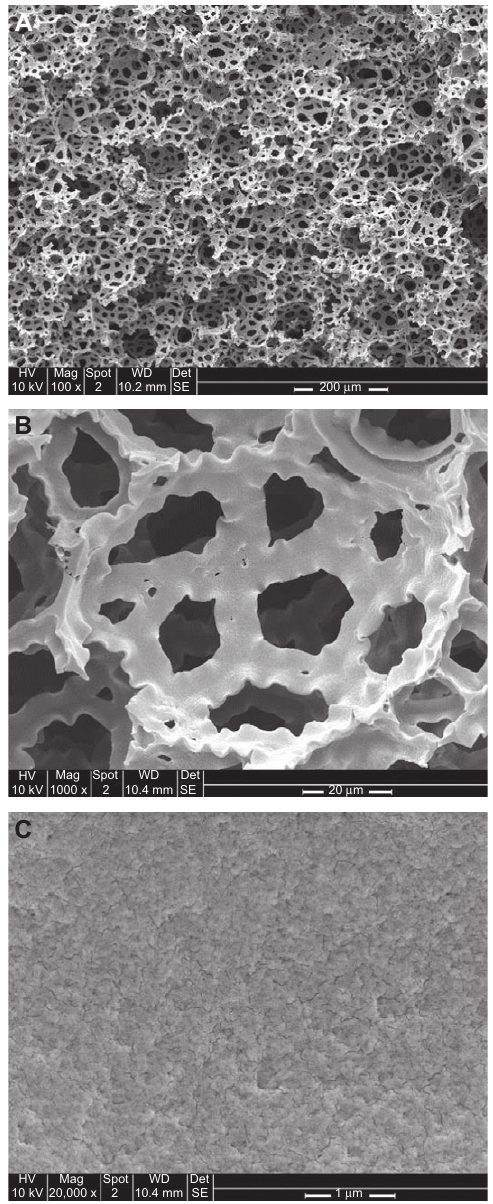
Figure 1 Scanning electron micrographs of the sulphonated- neutralised polyHIPE polymer used as synthetic rhizosphere soil additive in grass growth experiments.